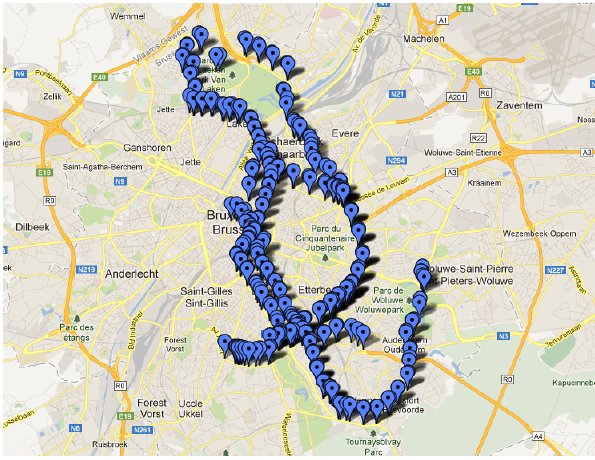
Figure 11. Lines intersecting at the “BUYL”